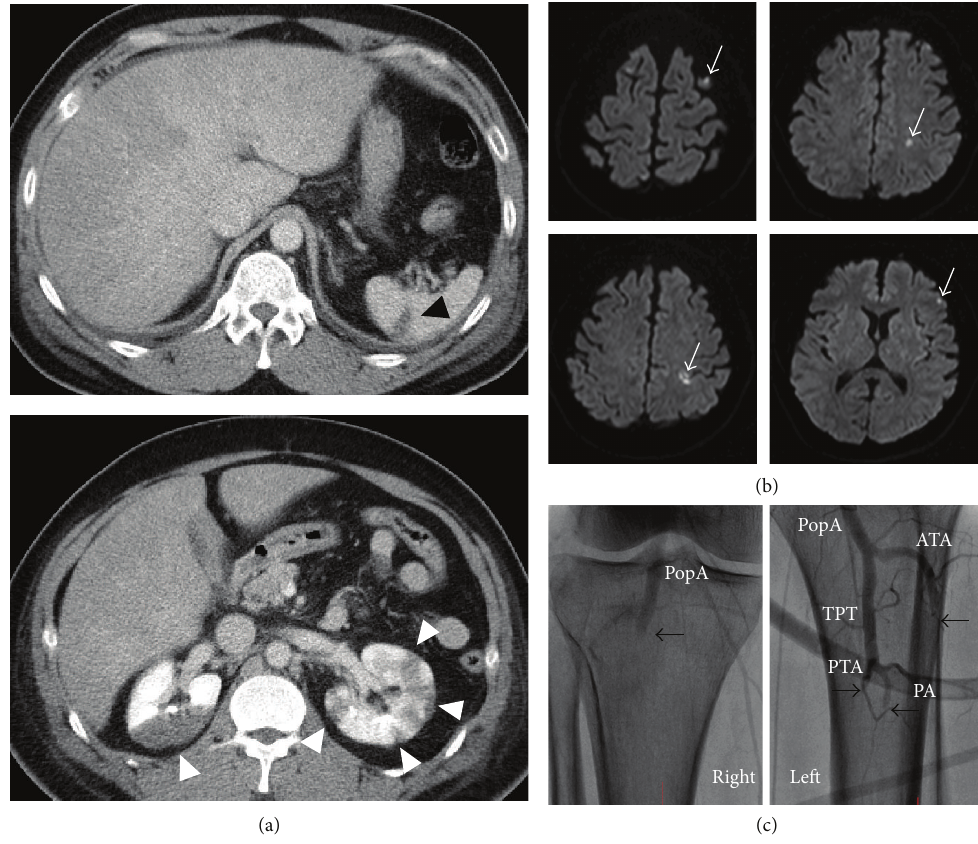
Figure 3: Imaging of systemic embolism. Axial views of contrast enhanced computed tomography on admission showed the splenic (black arrowhead)andrenal(whitearrowhead)embolisms(a).Also,headmagneticresonanceimaging(diffusionweightedimage)revealedcerebral infarctions (white arrow), which suggested they were due to shower cardiogenic embolism (b). Angiograms of bilateral below-the-knee arteries showed occlusions in the right popliteal artery (PopA), left anterior tibial artery (ATA), left peroneal artery (PA), and left posterior tibial artery (PTA) ((c); black arrows). TPT: tibioperoneal